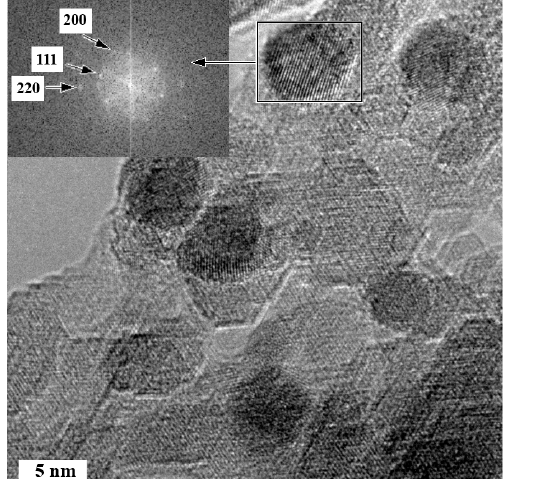
Table 1. Evaluation of the catalytic activity of various catalysts. +CH 3 CH 2 OH Cu-Pd/(M) γ -Al 2 O 3 H 2 O, N 2 , 453 KNO 2 NH 2